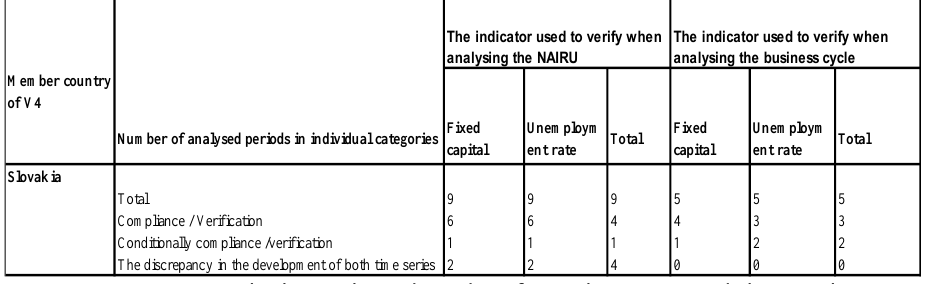
Table 1. Verification Result of the Indicator perception of uncertainty among companies and NAIRU respectively the economic cycle (the number of periods)